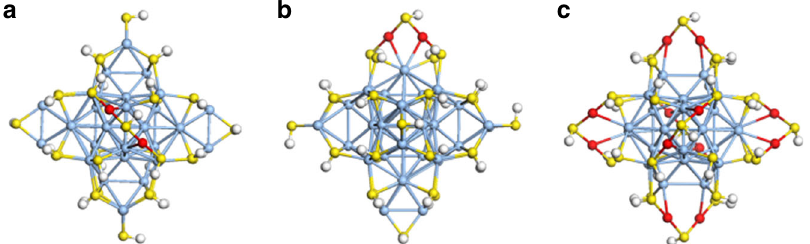
Fig. 8 DFT-optimized structures of Ag 44 − x @Au x nanoclusters. a Top and b side views of one outer shell Ag 2 (SR) 5 motif of [Ag 44 (SR) 30 ] 4 − (SR denotes thiolate ligand; color legend: Ag (light blue), S (yellow), and H (white)) substituted by Au (red) and the formation of the Au staple motif, and c proposed structure of [Ag 32 @Au 12 (SR) 30 ] 4 − by complete replacement of 12 outer shell Ag atoms. For ease of computation, the – SR is simpli fi ed as – SH